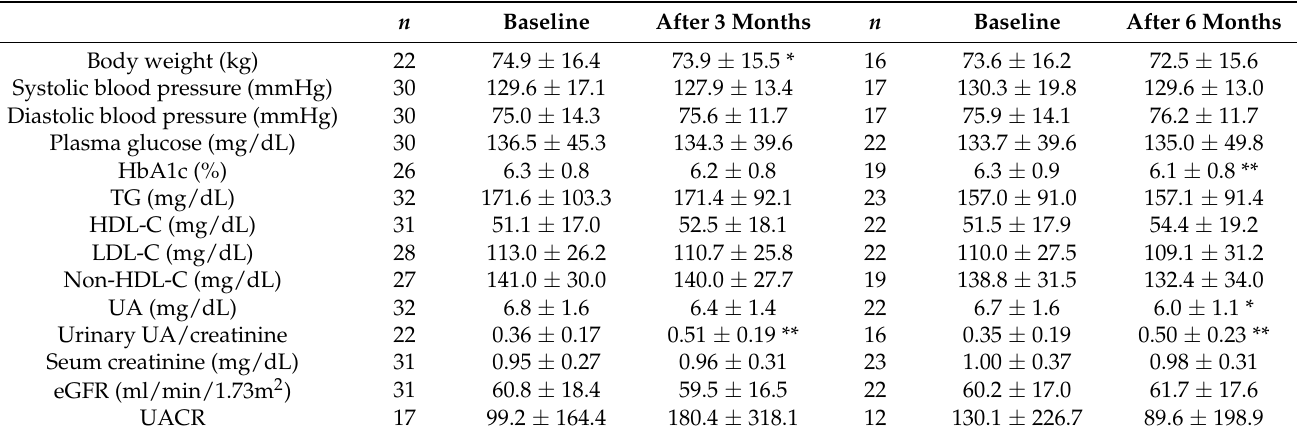
Table 9. Changes in metabolic parameters after the start of dotinurad in patients who had not taken anti-hyperlipidemic drugs ( n = 35). n Baseline After 3 Months n Baseline After 6